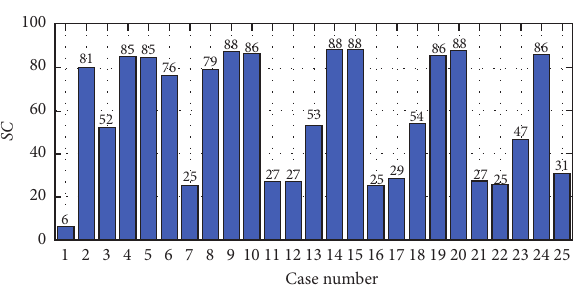
Figure 12: The values of SC with different case number. Table 4: Result